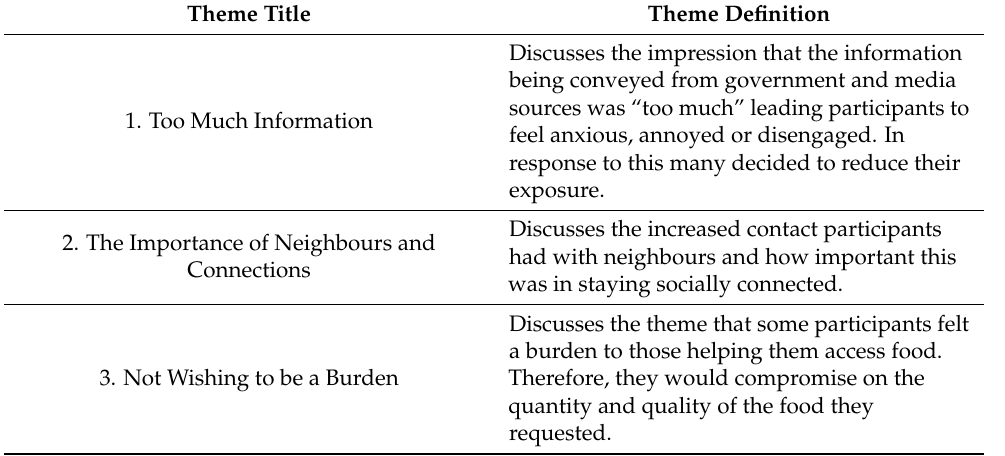
Table 2. Summary of